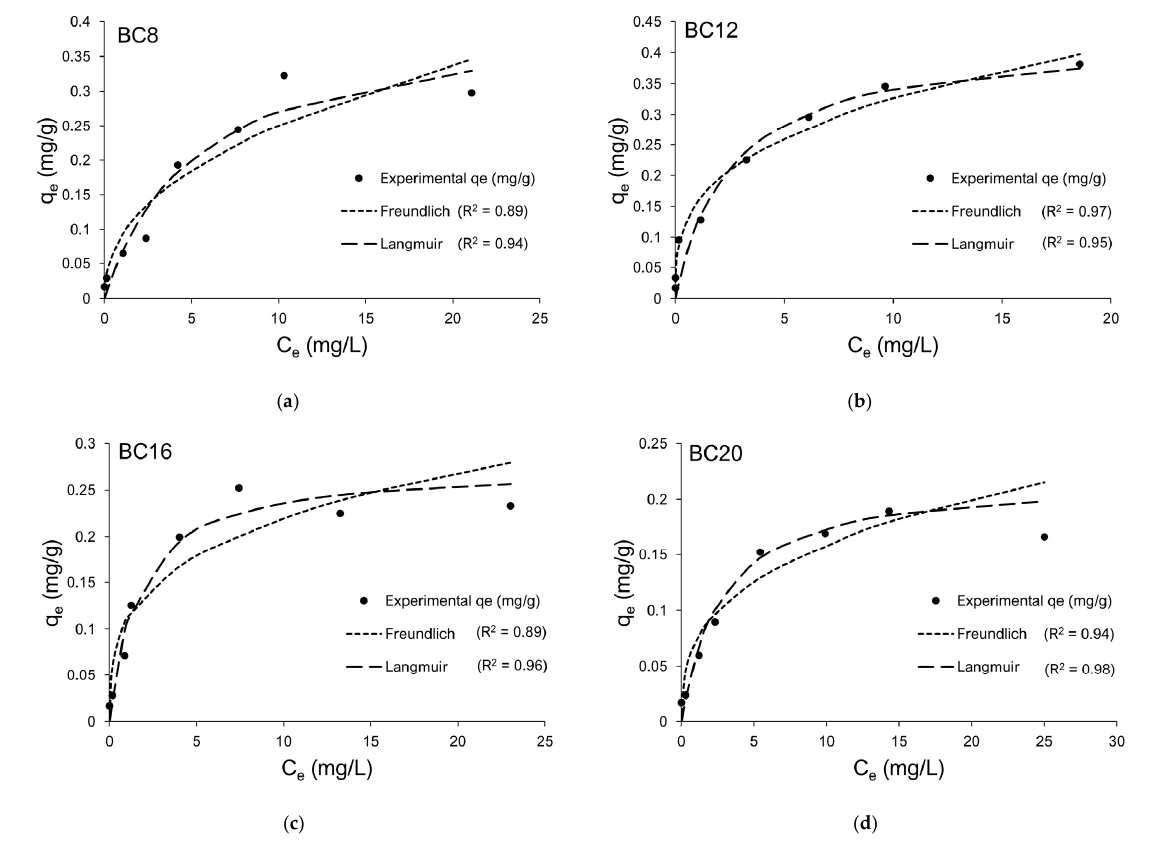
Figure 7. Removal efficiency (E) and experimental q e for: ( a ) BC8; ( b ) BC12; ( c ) BC16; ( d ) BC20. Uppercase and lowercase letters indicate significant differences among E and q e , respectively.